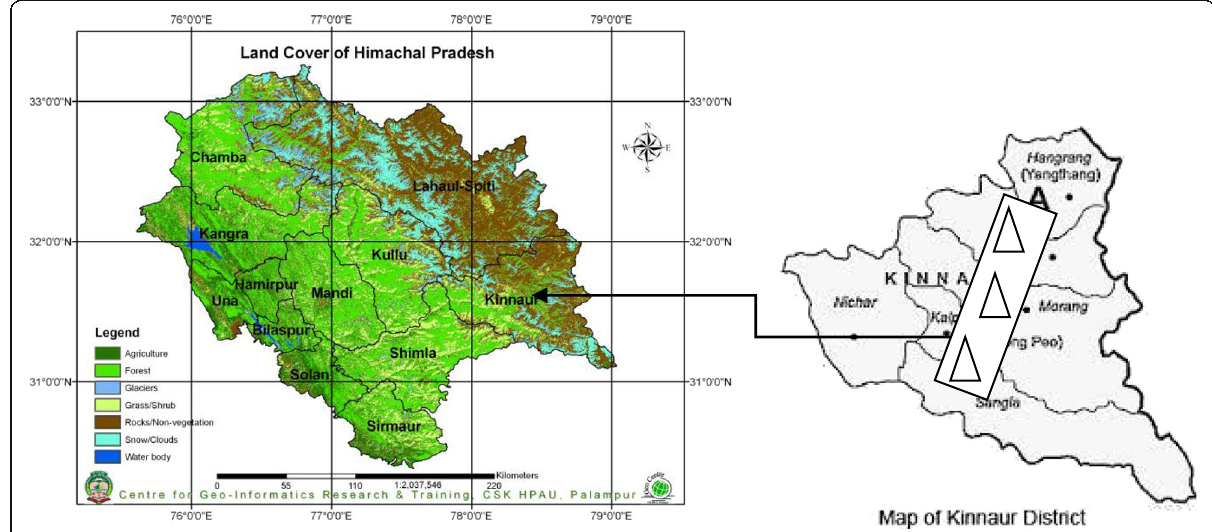
Fig. 1 Map of Himachal Pradesh showing location of experimental sites